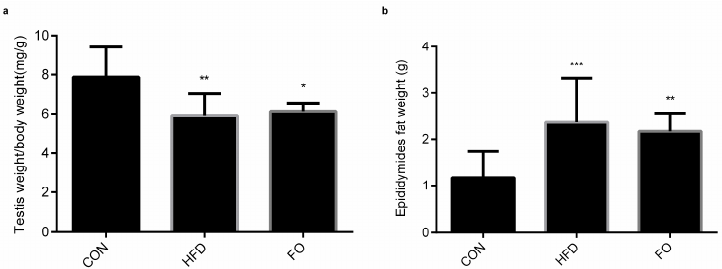
Figure 2. Effect of HFD and FO on male reproductive organs. ( a ) the relative ratio of testes weight/body weight ( b ) the epididymal fat weight. Data were expressed as mean ± SD ( n = 10 per group). * p < 0.05, ** p < 0.01, *** p < 0.001 vs. CON group.